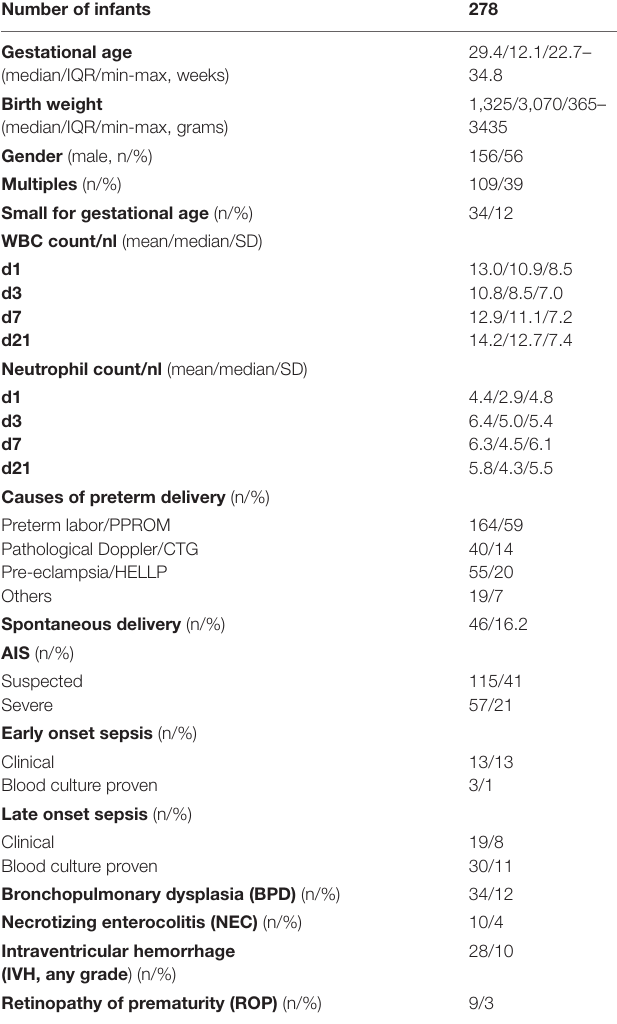
levels of LF ( Figure 1 ) as well as HNP1-3 ( r = 0.31, p = 0.01, n = 69 ( Supplementary Table 1 ). In line with that, LF ( r = 0.50, p < 0.001, n = 96) and HNP1-3 levels ( r = 0.30, p = 0.012, n = 69) were associated with birth weight in this subgroup. We found no influence of gender, multiple births or SGA on APP levels (data not